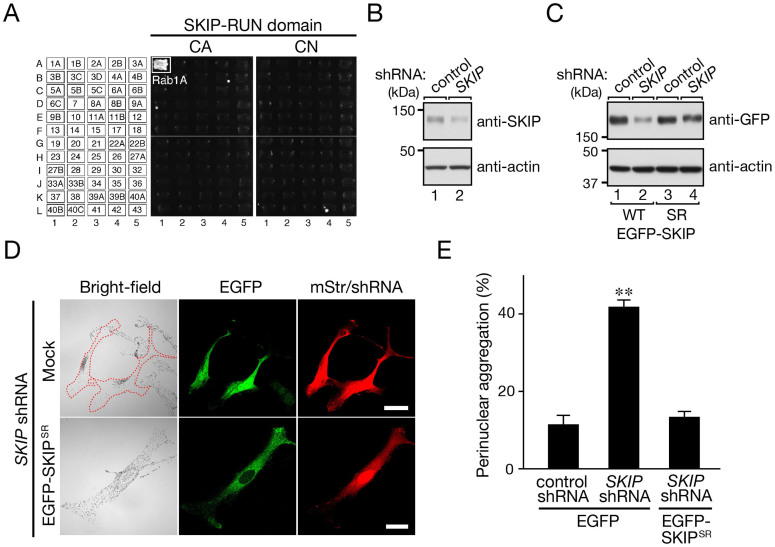
Functional involvement of SKIP in melanosome distribution in melanocytes.(A) Rab binding specificity of the RUN domain of SKIP as revealed by yeast two-hybrid panels2254. Yeast cells containing pGBD-C1 plasmid expressing each of the 60 constitutively active/constitutively negative (CA/CN) Rabs (positions indicated in the left panels) and pAct2-SKIP-RUN were streaked on SC-AHLW and incubated at 30°C for 1 week. Note the specific, GTP-dependent interaction between SKIP-RUN and Rab1A. (B) Knockdown of endogenous SKIP protein in melan-a cells with the specific SKIP shRNA. The positions of the molecular mass markers are shown on the left. (C) Characterization of an shRNA-resistant (SR) SKIPSR mutant. (D) Knockdown of SKIP in melanocytes resulted in perinuclear melanosome aggregation. Melan-a cells were cotransfected with pSilencer-mStr-SKIP and either pEGFP-C1 (top row) or pEGFP-C1-SKIPSR (bottom row). Cells exhibiting perinuclear melanosome aggregation are outlined with broken lines. Note the clear perinuclear melanosome aggregation in the SKIP-deficient cells (top left panel), whereas re-expression of SKIPSR completely restored peripheral melanosome distribution (bottom left panel). (E) Quantification of the results shown in (D). The results are expressed as the percentages of transfected cells that exhibited perinuclear melanosome aggregation, and the bars represent the means and S.E. of the data from three independent experiments (n >50). **, p <0.01 in comparison with the control cells (Dunnett's test). Scale bars, 20 μm.